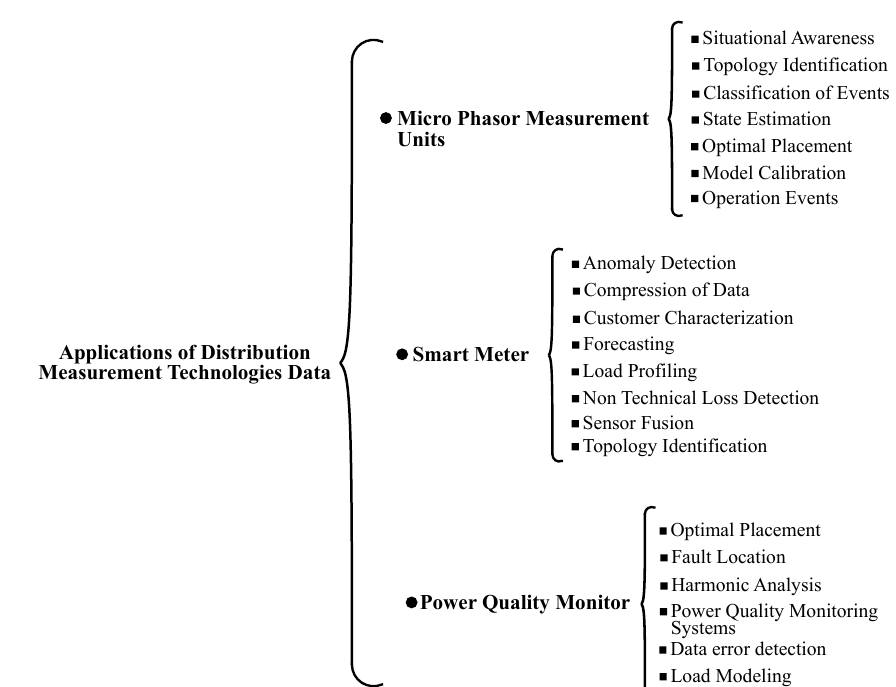
Figure 5. Applications of Distribution Measurement